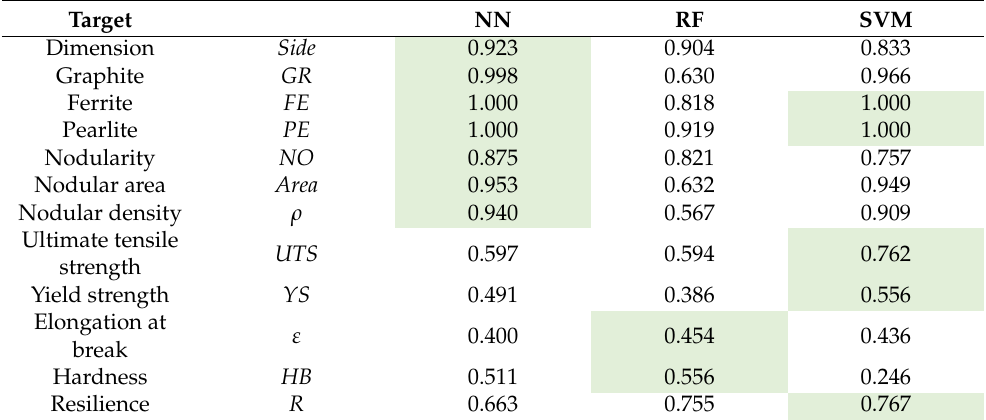
Table 7. Model accuracy in the prediction of the different variables as the target (according to R 2 ): for each target, the highest accuracy in predictions is